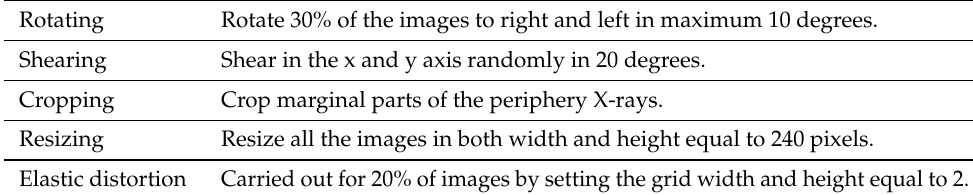
Table 1. Manipulation of the X-ray images before augmentation. Rotating Rotate 30% of the images to right and left in maximum 10 degrees. Shearing Shear in the x and y axis randomly in 20 degrees. Cropping Crop marginal parts of the periphery X-rays. Resizing Resize all the images in both width and height equal to 240 pixels. Elastic distortion Carried out for 20% of images by setting the grid width and height equal to